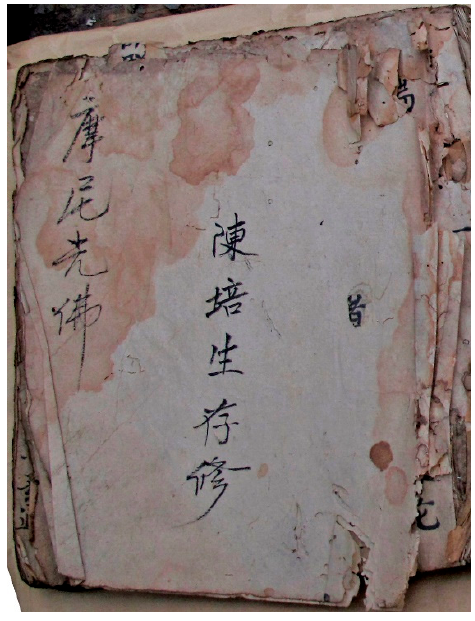
Figure 1. The front cover of Mani the Buddha of Light (Yang and Bao 2015, p. 74).